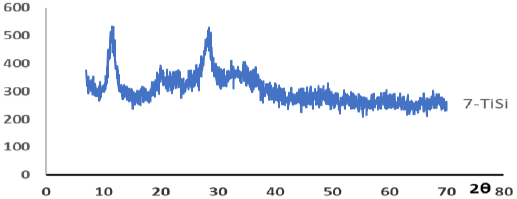
Figure 3. A gray-brown powder-TiSi fraction (left) and a carbon-TiSi fraction (right)—the products of titanium silicates precipitated on the rice husk biochar (usual images at small magnification). Samples obtained with both methods were synthesized in potassium form, when potassium